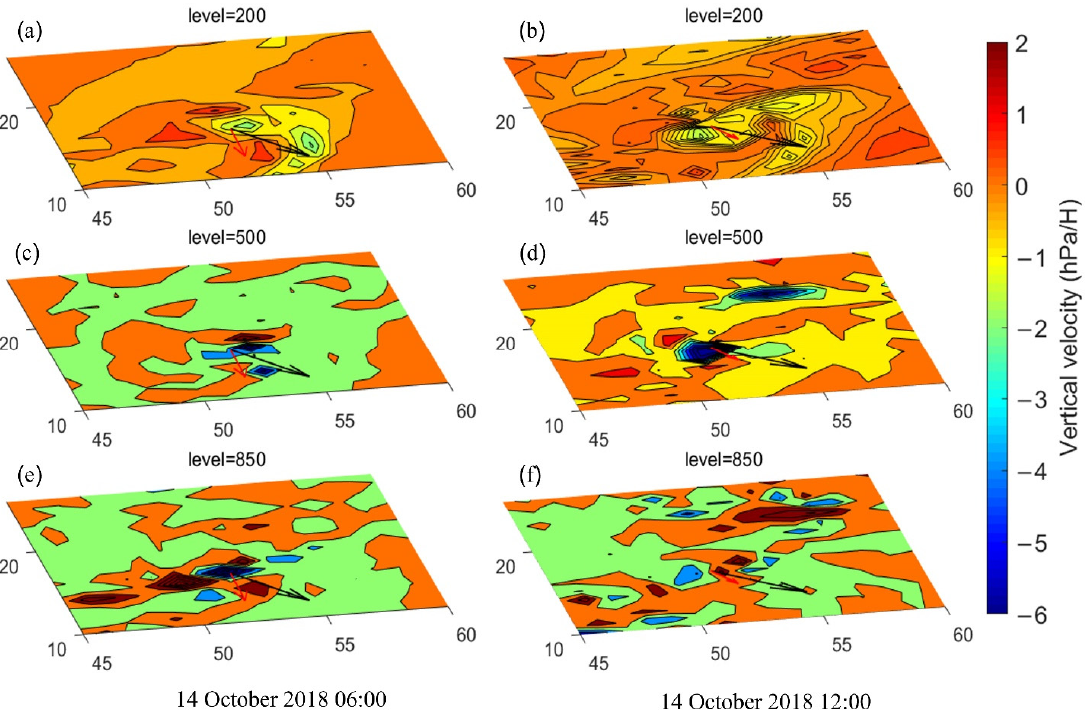
Figure 9. The vertical velocity (hPa/H) distribution of Luban during ( a , c , e ) and after landfall ( b , d , f ) at level = 850, level = 500, and level = 200. The black arrow represents the deep ‐ level environment VWS, and the red arrow represents the low ‐ level environment VWS.